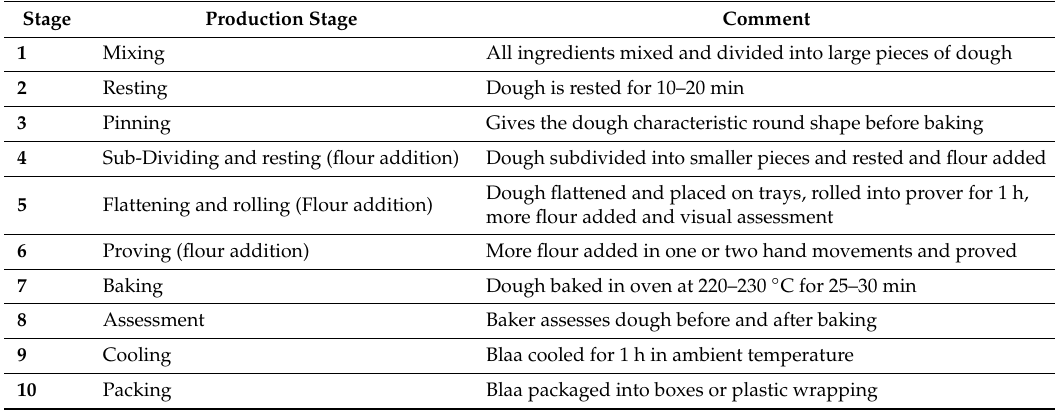
Table 1. Stages of Waterford Blaa production.